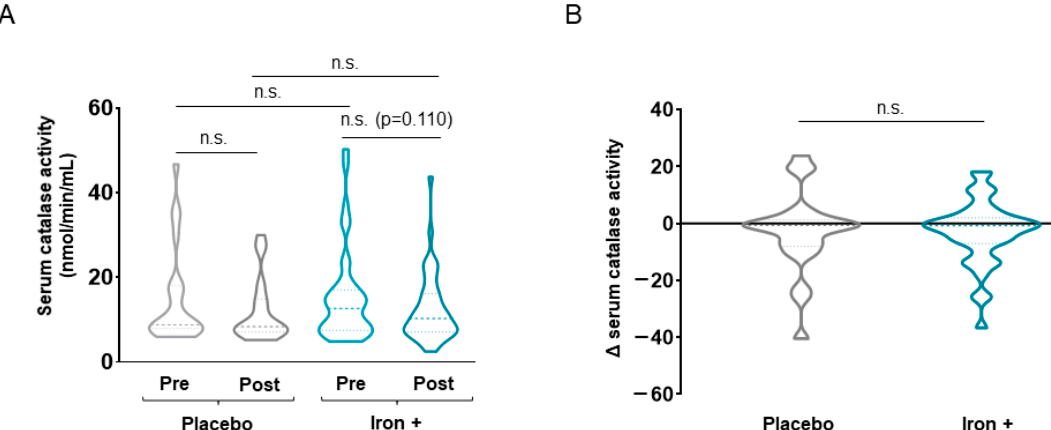
Figure 7. Violin plots of absolute catalase activity in serum of all COPD patient groups ( A ) and delta (post-pre) of serum catalase activity levels in placebo and iron-treated groups ( B ). The dashed line represents the median and the dotted lines the interquartile ranges. Statistical significance: n.s., no significance.